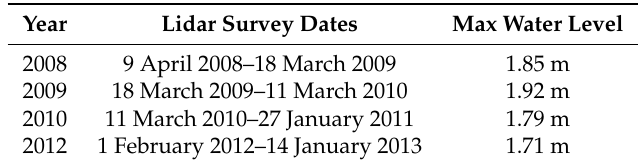
Table 3. Years in which the aggregated transport formula was evaluated with their respective LiDAR survey dates and the maximum water level per